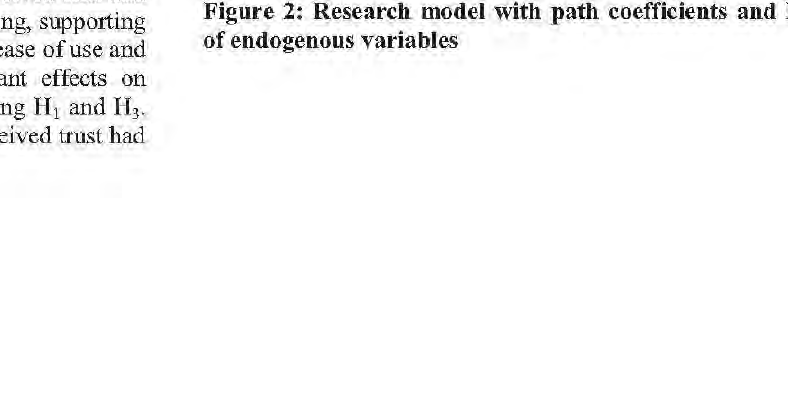
Figure 2: Research model with path coefficients and R